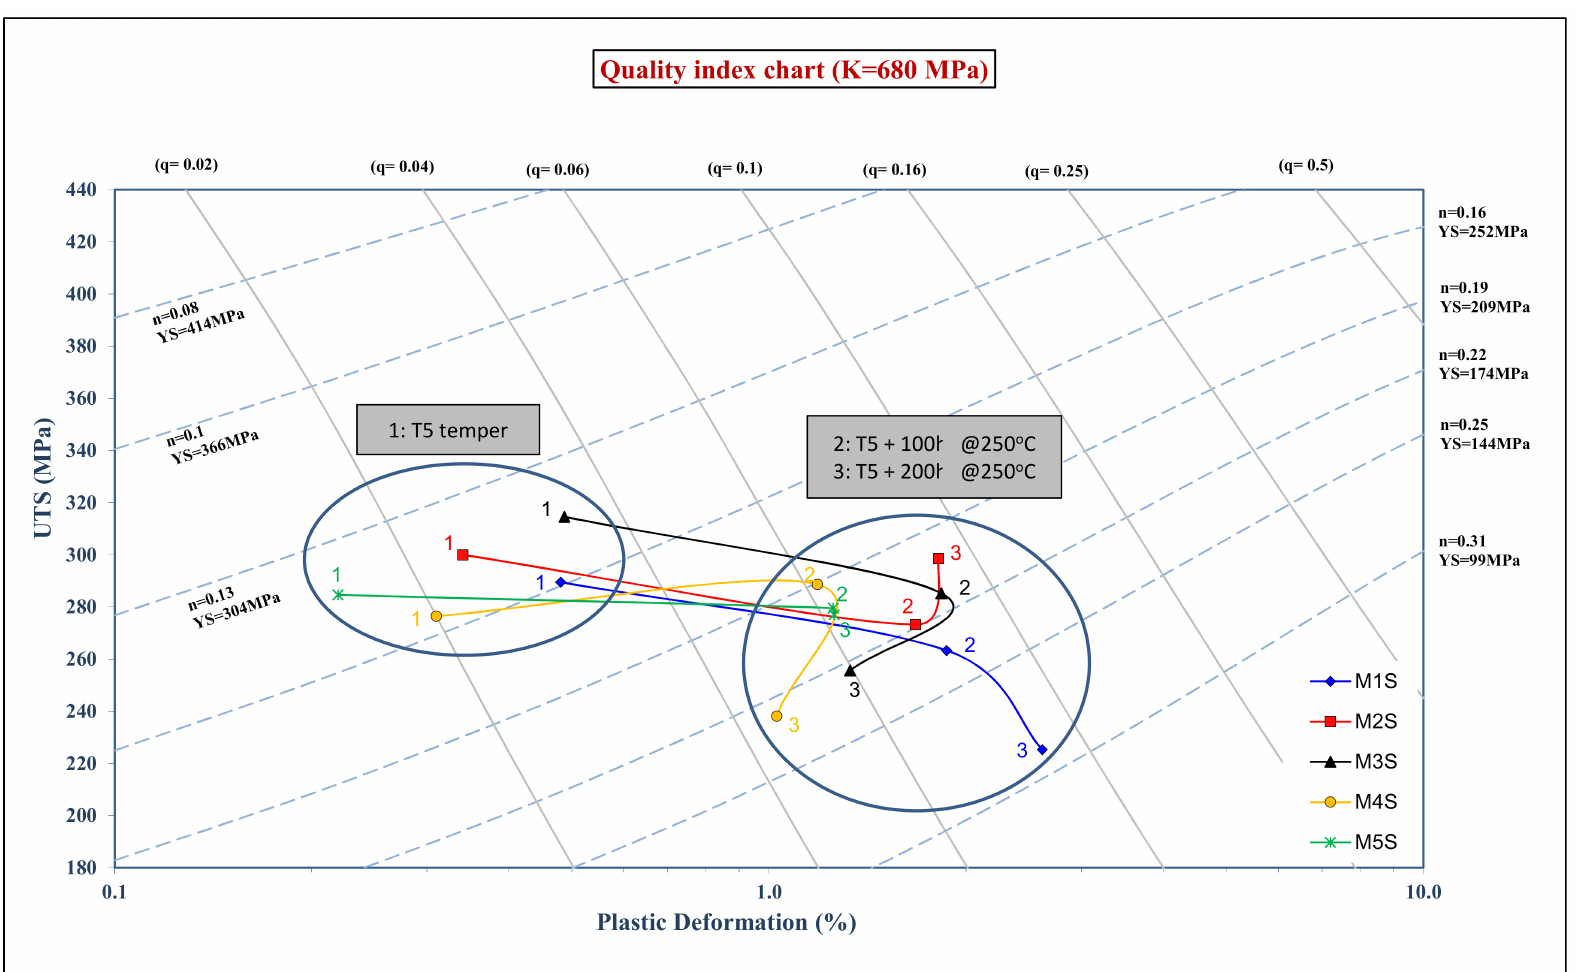
Figure A1. C á ceres quality chart representing the relation between UTS and percent plastic deformation of alloys M1S through M5S in the T5 condition before and after stabilization at 250 ◦ C for 100 and 200 h (testing at ambient